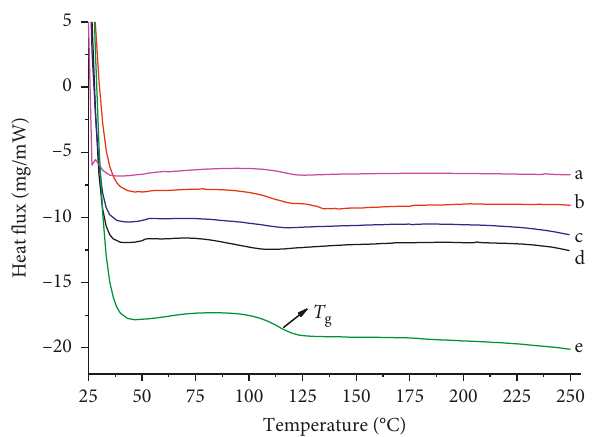
Figure 1: Nonisothermal DSC curves of (a) A, (b) D, (c) E, (d) C, and (e) B